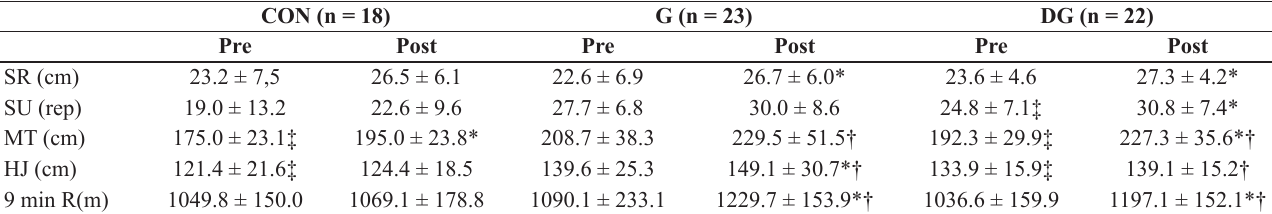
Table 2. Mean values (±SD) results in the physical fitness tests pre and post intervention (n=63). CON (n = 18) Pre Post